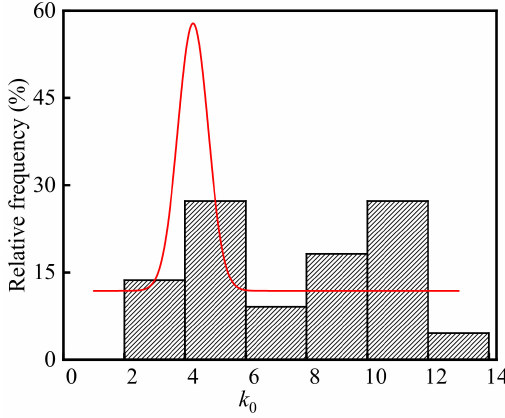
Figure 9. Frequency distribution histogram of k 0 .